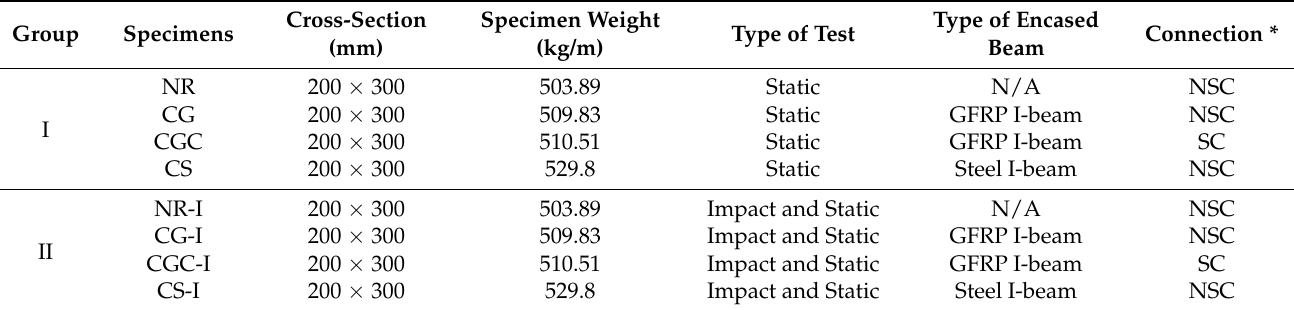
Table 1. Details of the tested